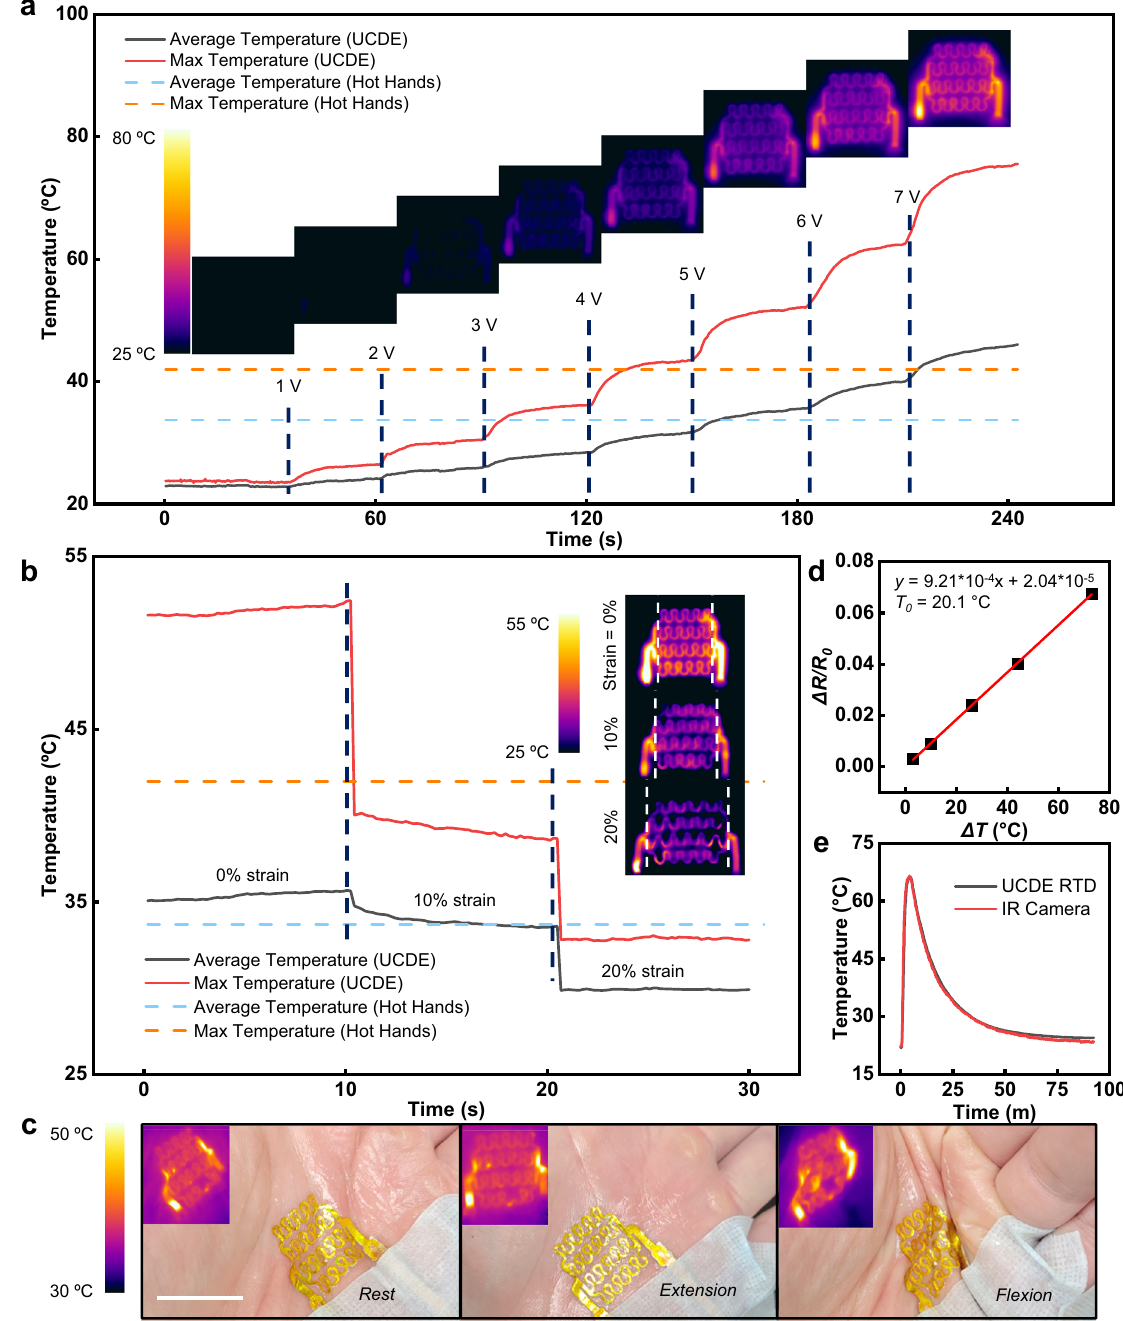
Fig. 3 Stretchable heater and RTD sensor developed from UCDEs. a The temperature evolution of the UCDE heater from 1 to 7 V DC bias voltage at 0% strain compared to commercially available hand warmers. Insets are the thermal pro fi les emitted from the UCDE heater, captured by an IR camera at corresponding voltages. b Characterization of the temperature output from the UCDE heater under deformation at 0, 10, and 20% strain. Insets are IR images of the UCDE heater under various strain deformations. c The stretchable UCDE heater is laminated on a palm and subjugated to commonplace hand deformations (rest, extension, and fl exion). Insets are the thermal pro fi les emitted from the UCDE heater while laminated on the palm (scale bar, 2.5 cm). d The calibration curve of the UCDE RTD sensor, 4 – probe resistance vs. temperature response of a thermocouple. e The temperature response of the UCDE RTD sensor compared with an IR